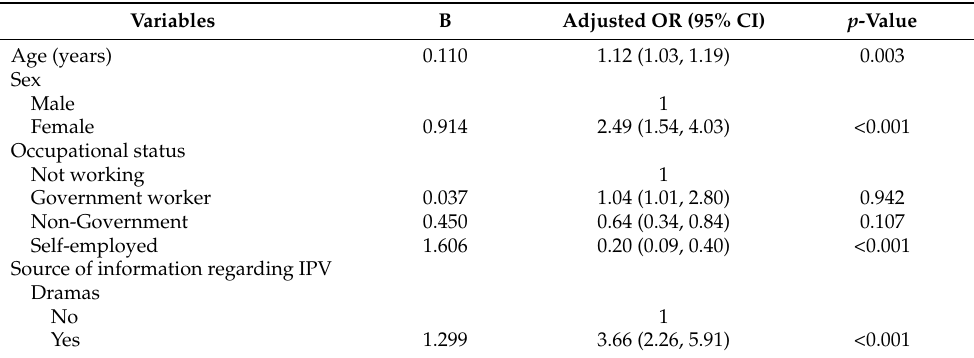
Table 4. Multiple logistic regression of the association between factors and attitudes towards rejecting IPV among premarital young adults in Kelantan (n =